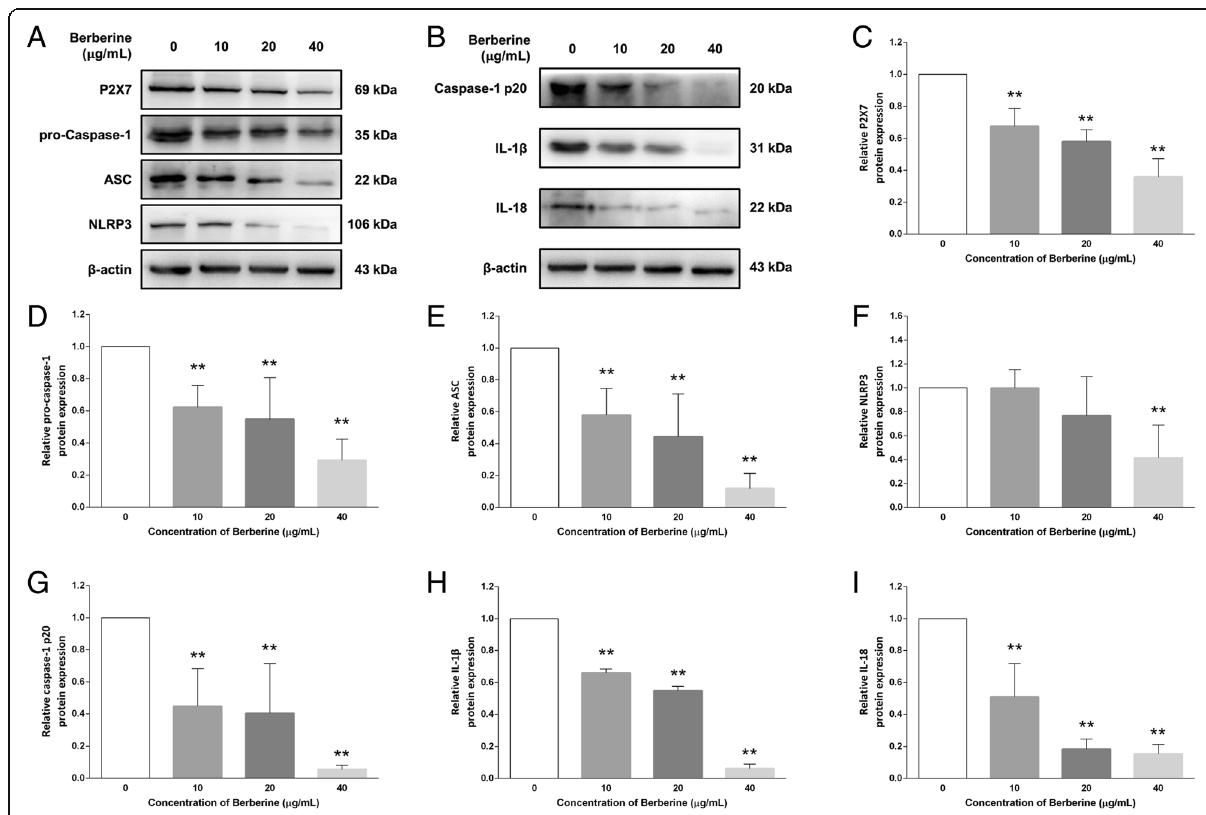
Fig. 6 Effects of BBR on the expression profile of NLRP3 inflammasome signaling proteins in MDA-MB-231 cells. After treatment with various concentrations of BBR for 48 h, the protein bands ( a ) and ( b ), as well as expression profile of NLRP3 inflammasome signaling proteins, ( c ) P2X7, ( d ) pro-caspase1, ( e ) ASC, ( f ) NLRP3, ( g ) caspase-1 p20, ( h ) IL-1 β and ( i ) IL-18, was analyzed using western blot as described in Material and methods. Significant difference between control and treatment with BBR are shown, * p < 0.05, ** p < 0.01. Representative image of the expression profile of each protein is shown from three independent